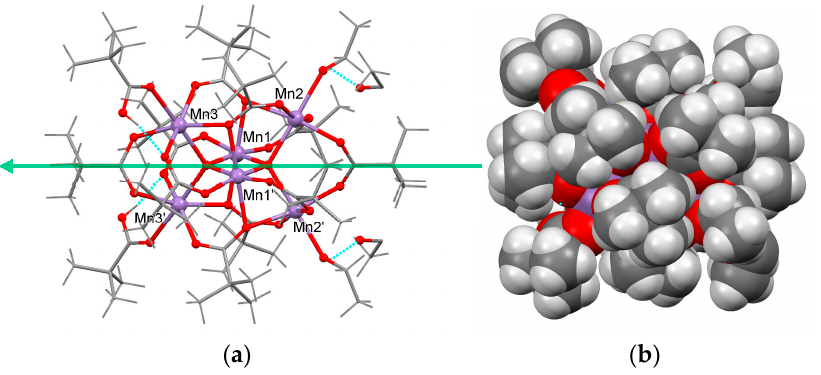
Figure 2. ( a ) View of the cluster and H-bonded ethanol molecules in 2. The green arrow shows the two-fold rotation axis passing through the cluster in the crystal structure. ( b ) Space-filling model. The second positions of disordered moieties are not shown.